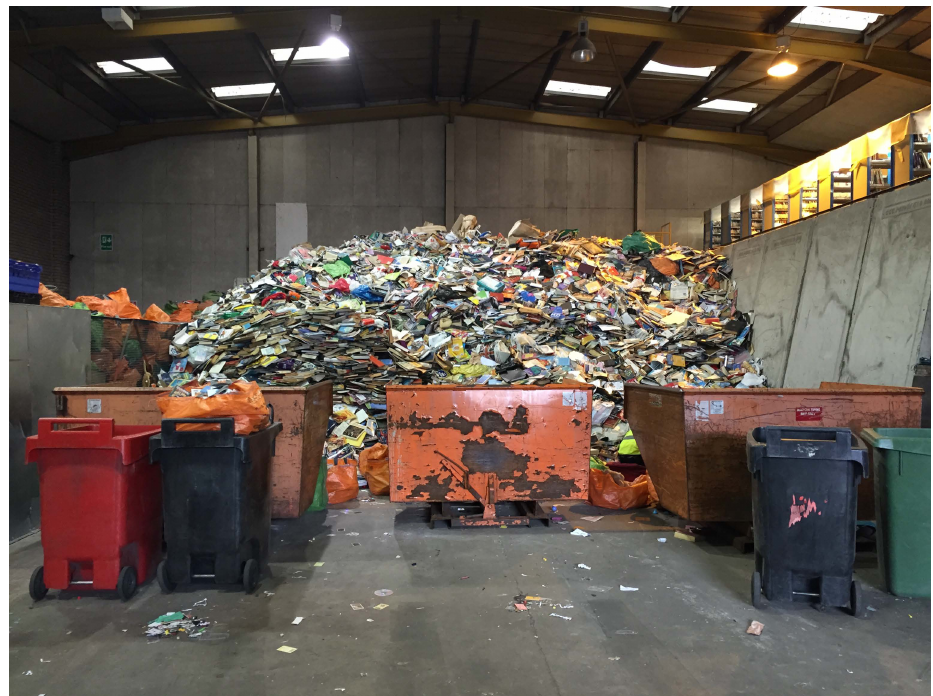
Figure 2. Books await sorting, workers crouching in high visibility vests at the base of the pile (one can be seen behind the tip on the right). Rejected books go into the orange tips. Shelves of books awaiting sale can be seen at upper right. Source: Photo by the